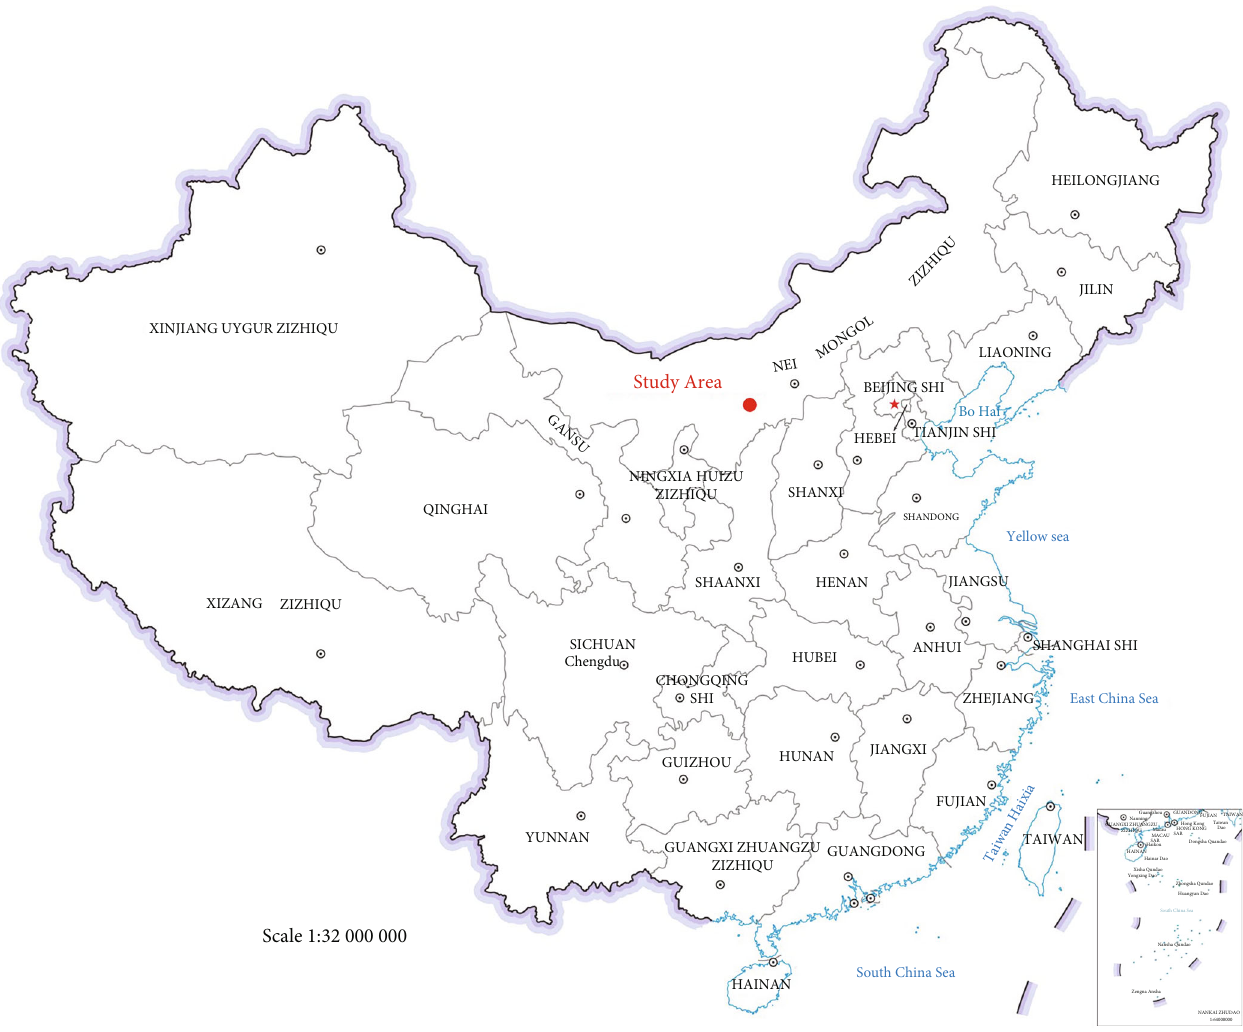
Figure 1: Geographical location of the study area.